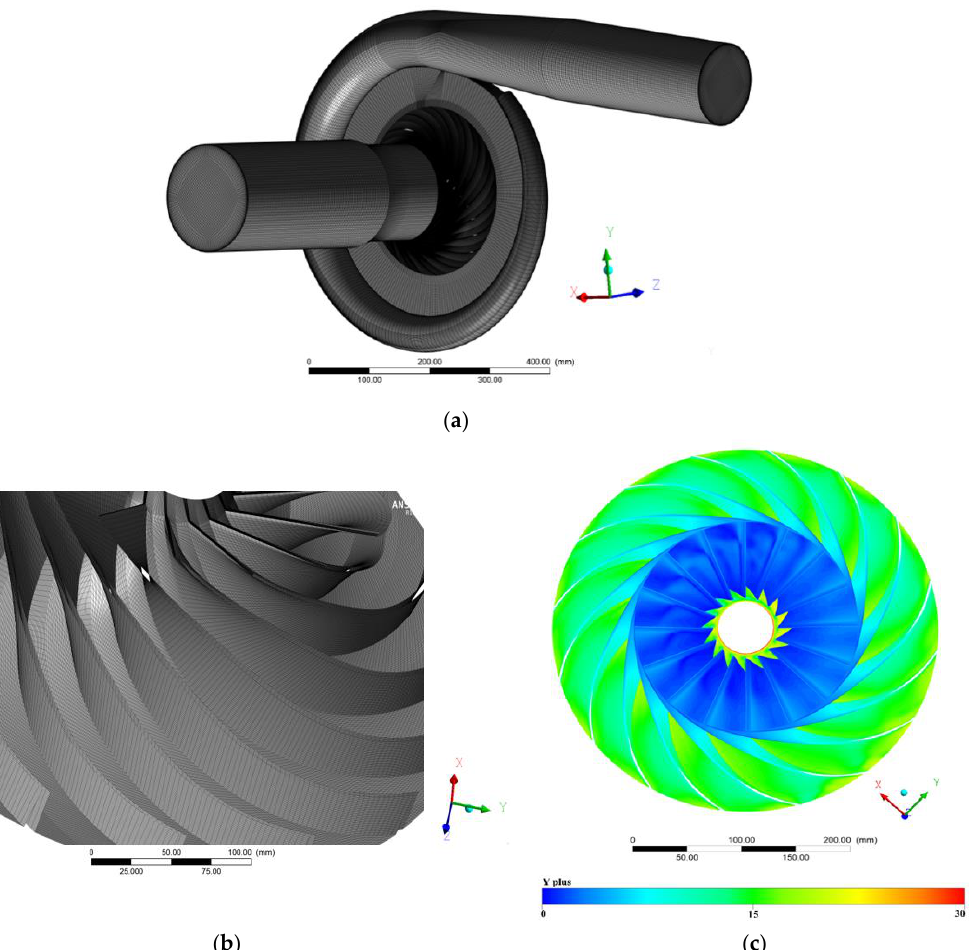
Figure 2. Overall grid division diagram of centrifugal compressor. ( a ) Grid of centrifugal compressor. ( b ) Grid of the impeller. ( c ) Distribution of y-plus values near the blades and impeller hub.